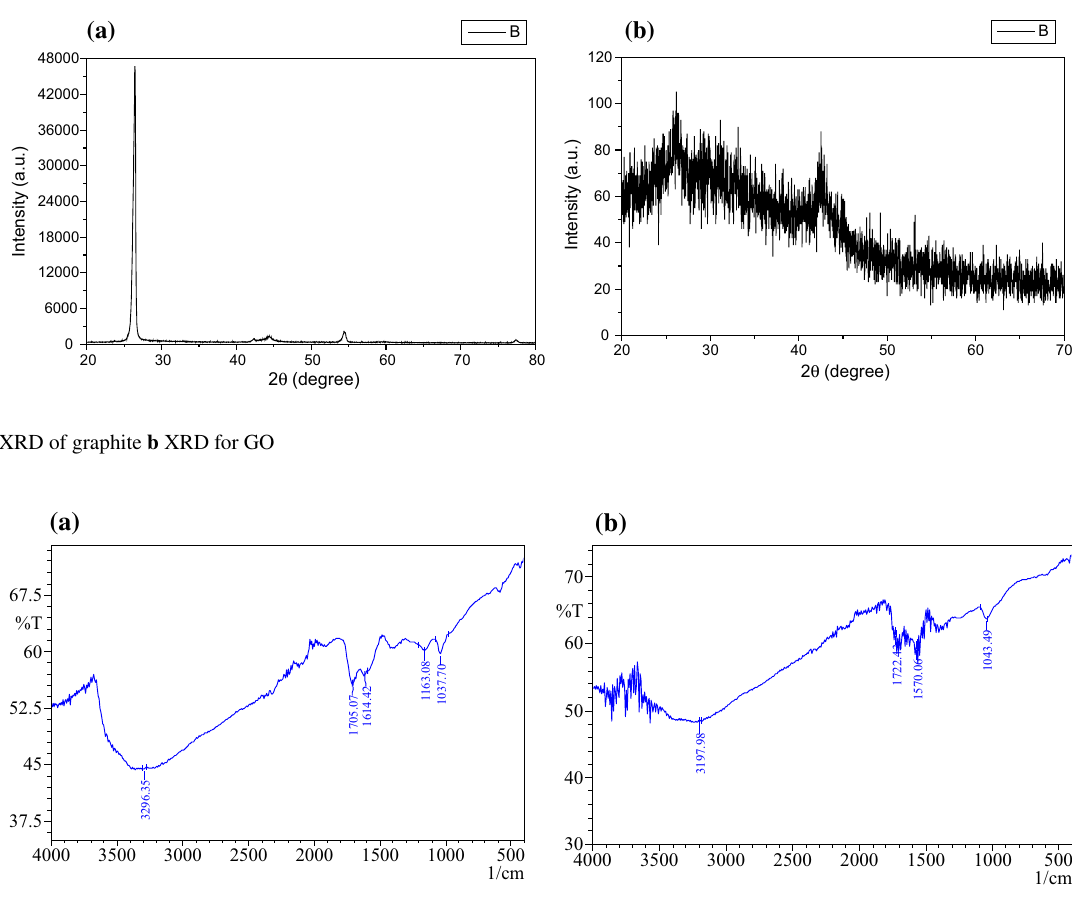
Fig. 4 a FTIR of GO before Cr(VI) removal b FTIR of GO after Cr(VI)